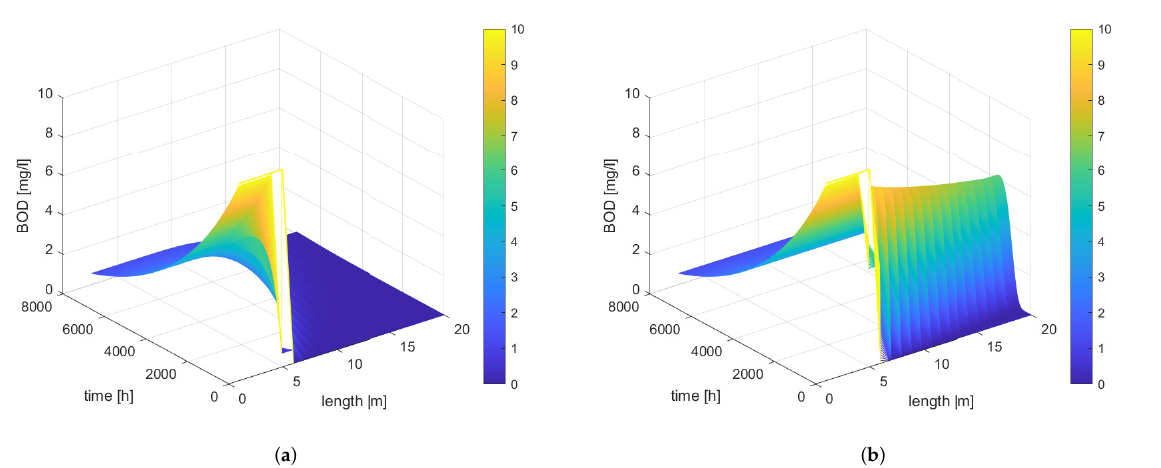
Figure 20. BOD distribution including the self-cleaning process without diffusion for V = 0.001 ( a ) V = 0.01 ( b